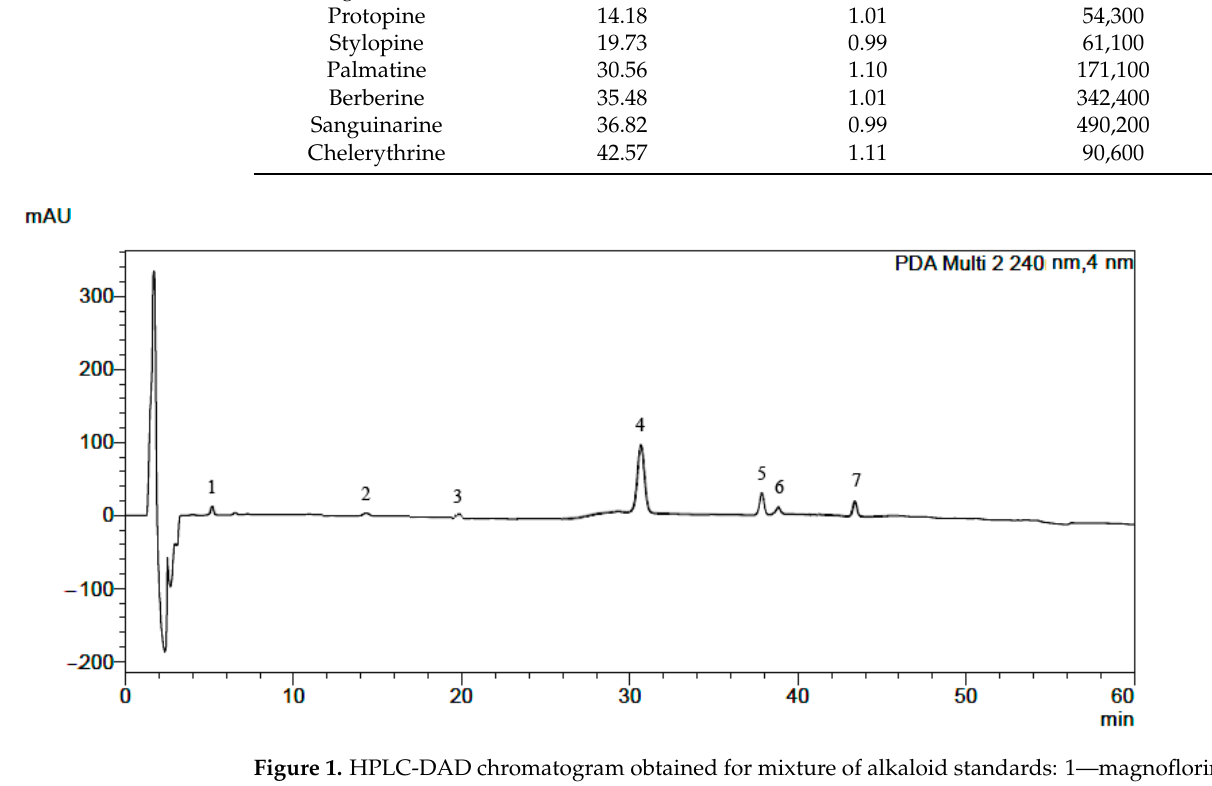
Table 1. Values of retention time (t R ), asymmetry factor (A S ), and theoretical plate number per meter (N/m) obtained for alkaloid standards.